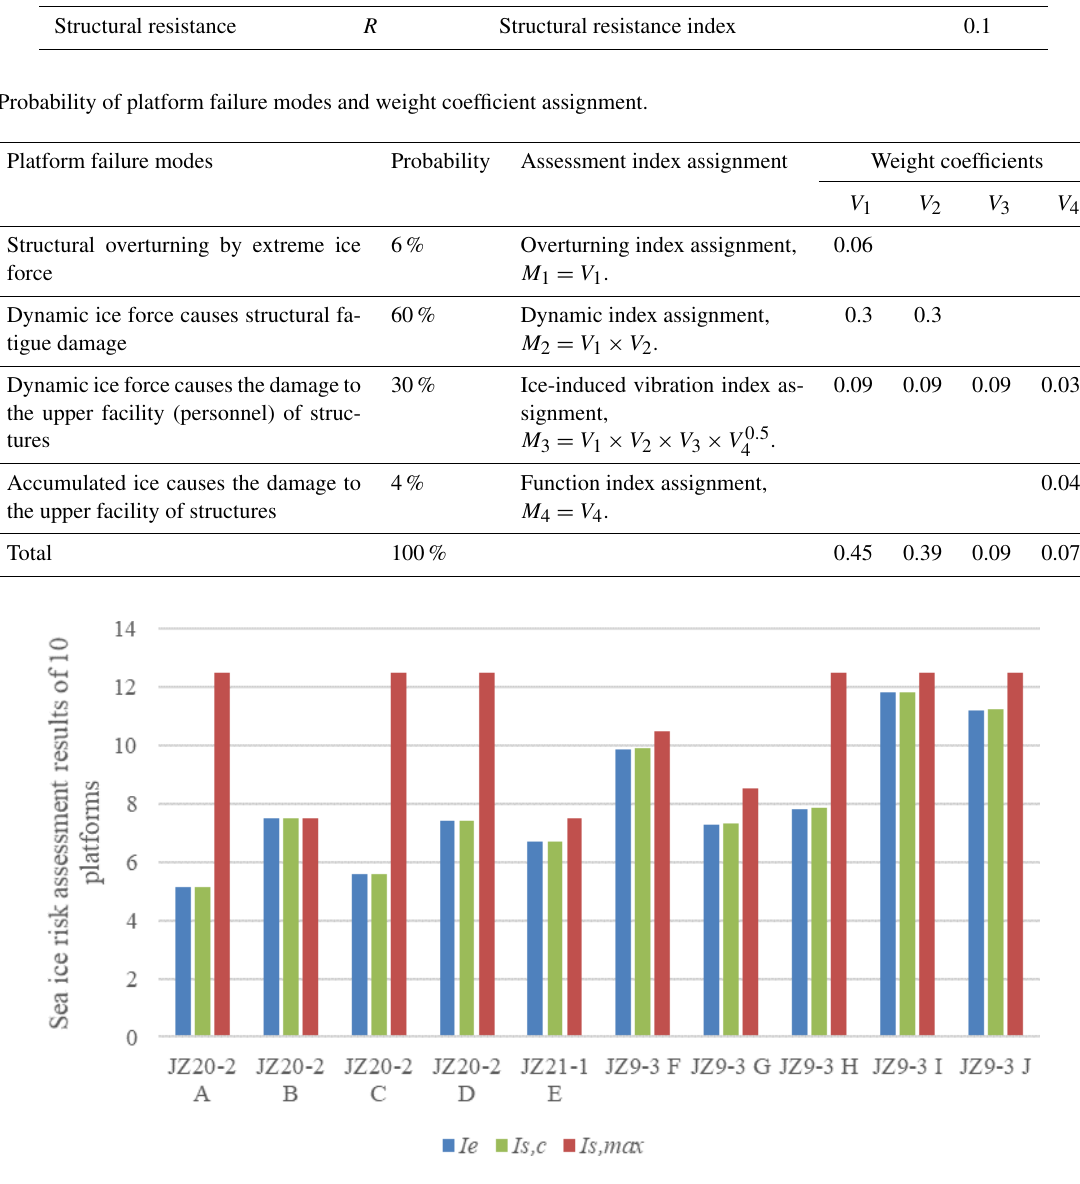
Figure 4. Comparison of the three risk calculation results ( I e , I s , and I s, max